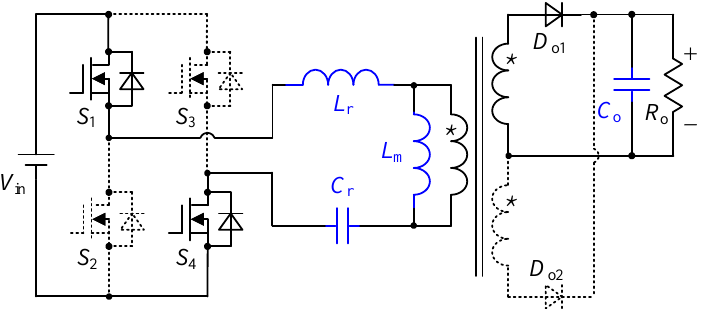
Figure 3. Equivalent circuit of LLC resonant converter in the positive half cycle.